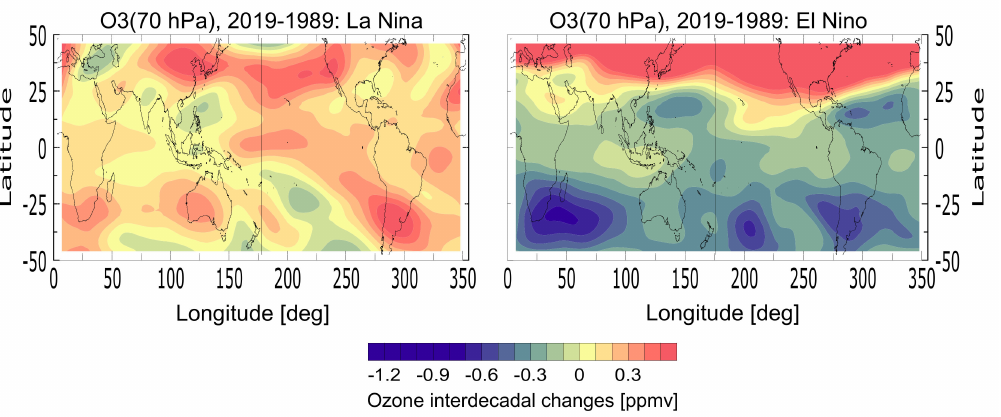
Figure 7. Multidecadal changes of the lower stratospheric ozone mixing ratio, calculated as a differ- ence between the decades 2010–2019 and 1980–1989, discriminated between for La Niña (left panel) and El Niño episodes (right